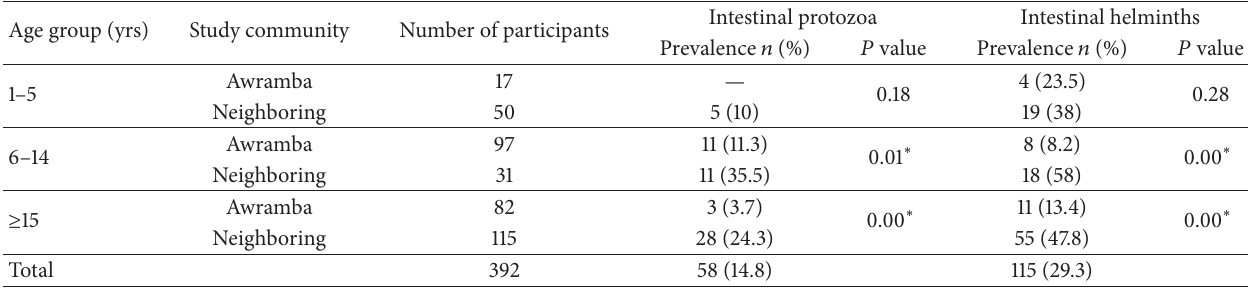
Table 2: Prevalence of intestinal helminth and protozoan infections among age groups of study participants in Awramba and its neighboring communities, Fogera Woreda, South Gondar Zone, Ethiopia (November 2010–April